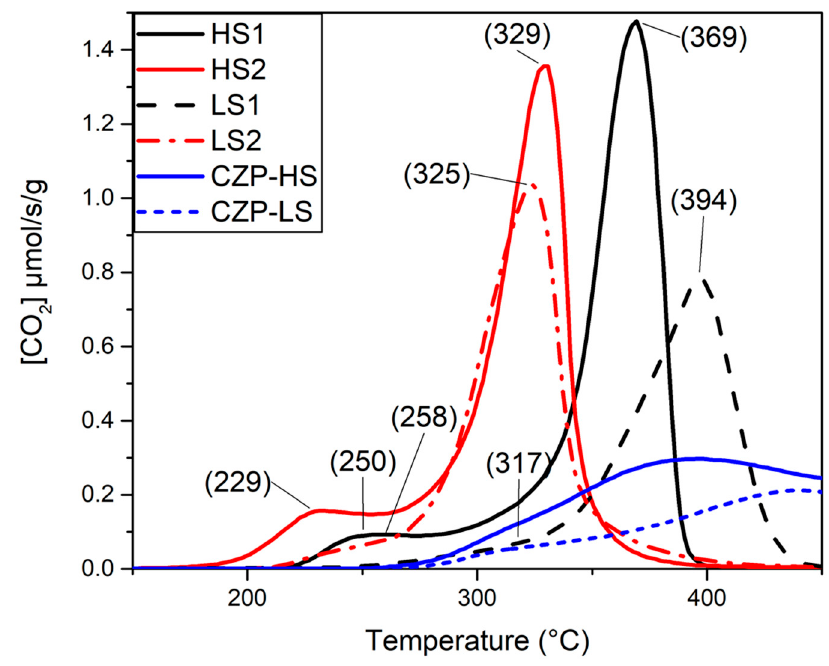
Figure 4. C 3 H 8 -TPR profiles for Pd-HS, Pd-LS and their bare